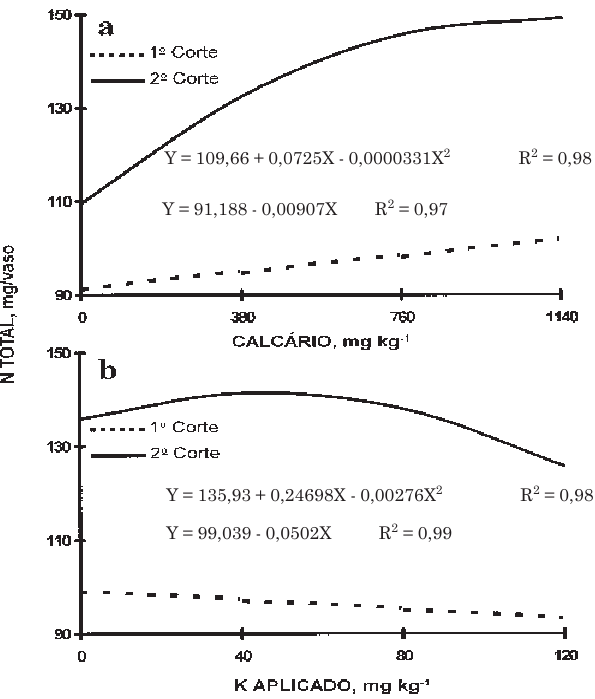
Figura 3. Concentração de nitrogênio na parte aérea da alfafa, em função das doses de calcário (a) e de potássio (b).